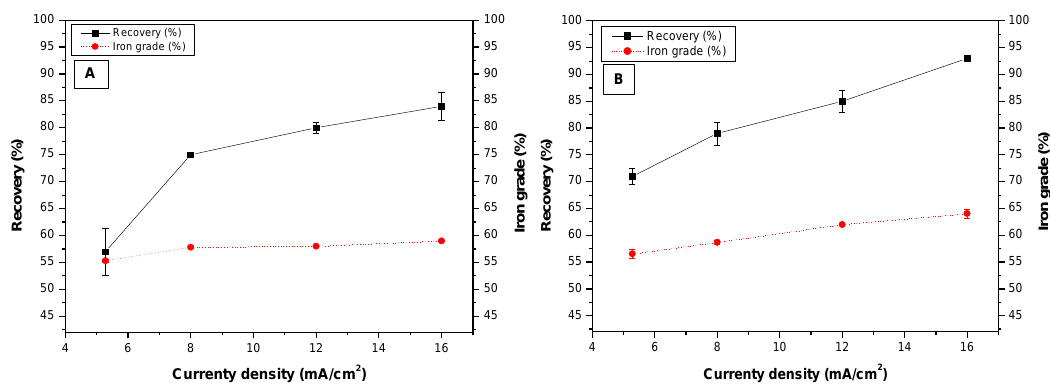
Figure 11. Electroflotation of iron ore as a function of current density. (biosurfactant): 300 mg/L, pH 3, agitation 300 rpm. ( A ): Particle size − 38 + 20 µm. ( B ): Particle size − 20 µm.